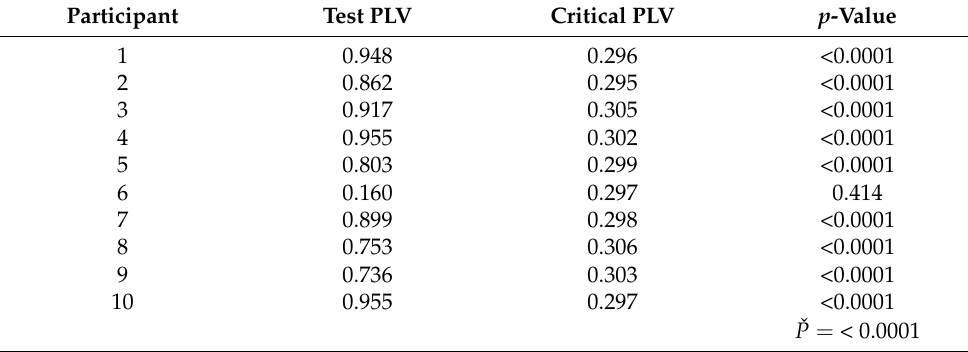
Table 2. Computed p -values of participant PD-Respiratory PLV against resampled (with replacement) distributions ( n = 10,000) under the null hypothesis that respiratory phase, which was randomized during resampling, bore no relationship to PD. Harmonic Mean p-value ( ˇ P ) was calculated by the Σ L i = 1 w i formula. ˇ P = , where L is the number of p -values, w i is the i th p -value weight (here all Σ L i = 1 w i / p i weights were 1/12), and p i is the i th p -value. Test